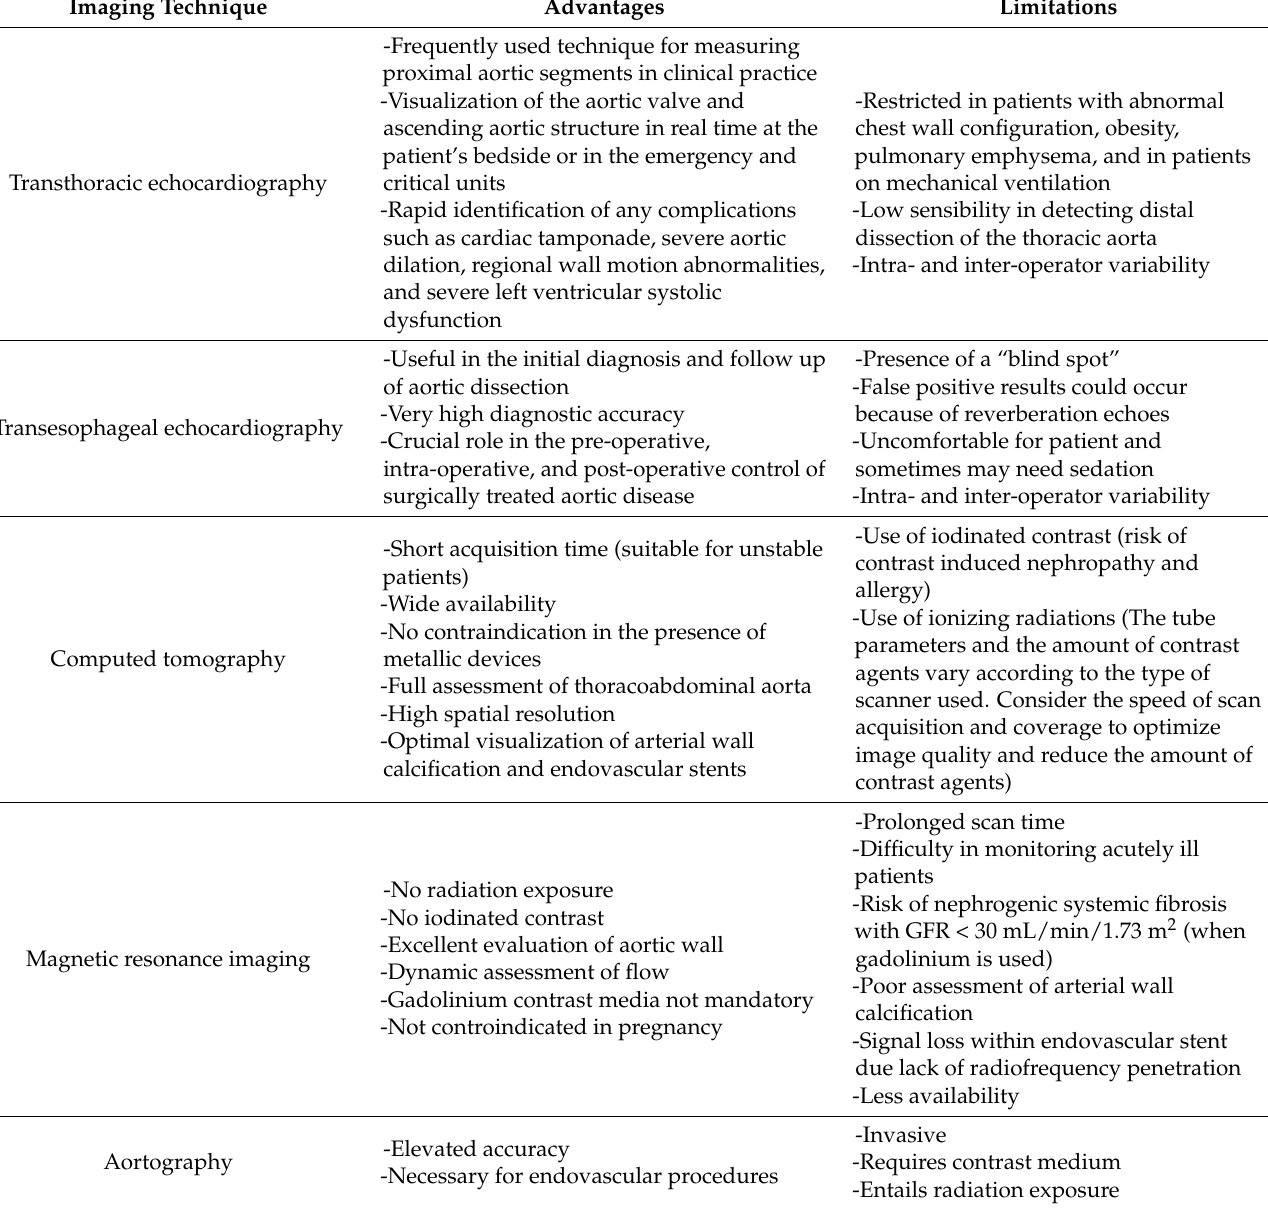
Table 1. Advantages and limitations of imaging techniques in the diagnosis of aortic